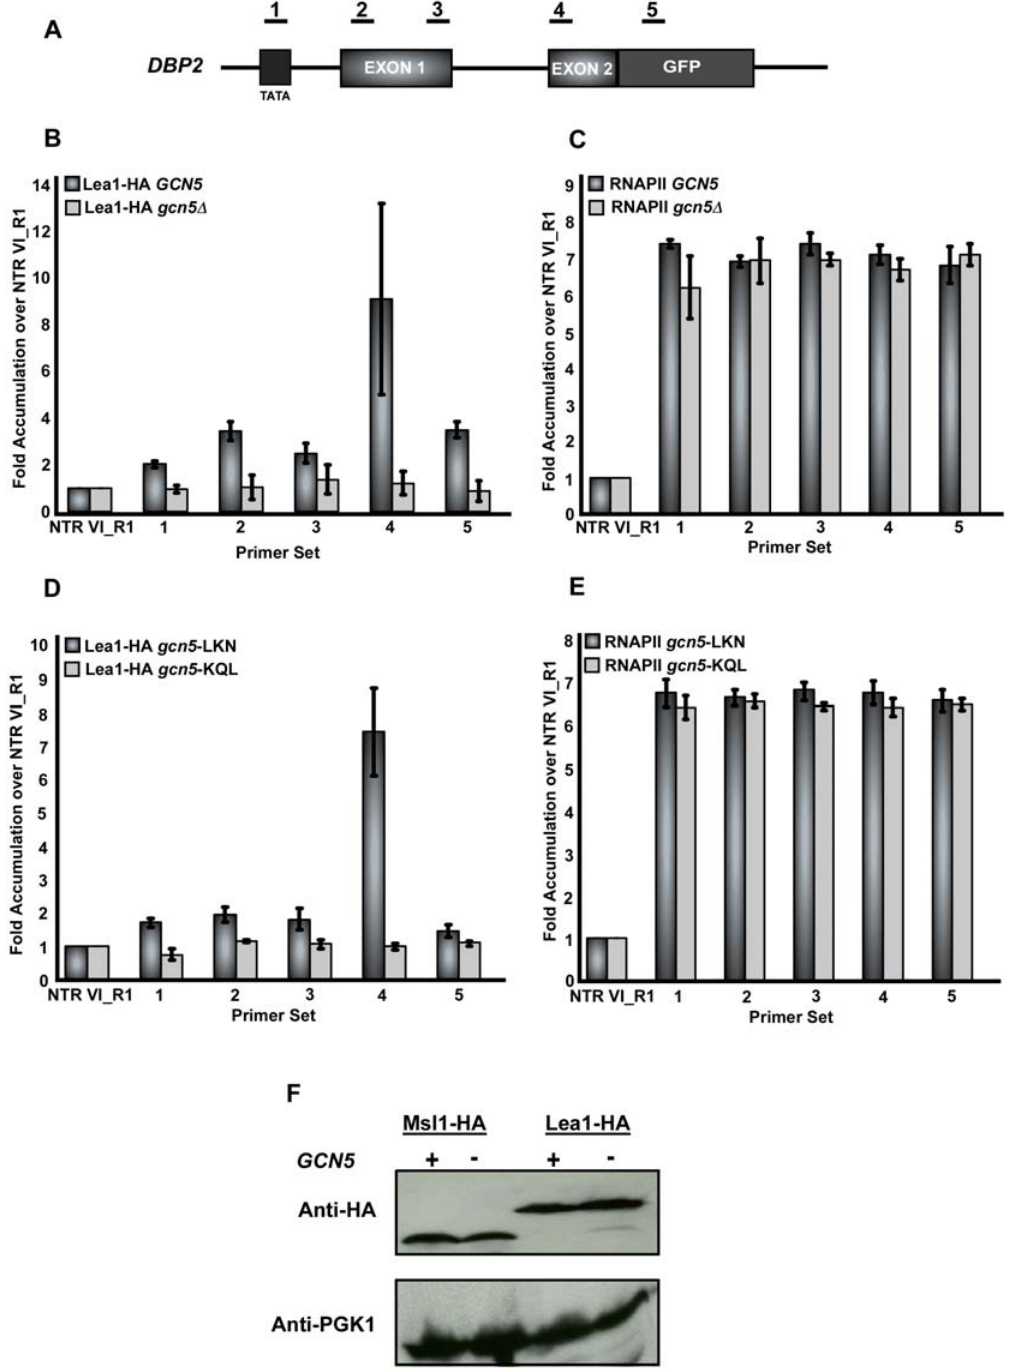
Figure 3. Deletion of GCN5 affects co-transcriptional recruitment of Lea1 to DBP2 . (A) Schematic of the intron-containing gene, DBP2 . Underlined numbers represent amplicons generated from each primer set used in the study. (B) Graph depicting the occupancy of Lea1 at each region of DBP2 relative to the non-transcribed region, in wild-type or gcn5 D . Dark grey bars represent Lea1 with wild-type GCN5 and light grey bars represent Lea1 levels in the gcn5 D strain. (C) Bar graph depicting RNA pol II occupancy within DBP2 relative to the non-transcribed control. Dark grey bars represent RNAP II occupancy in the LEA1-HA strain and light grey bars represent RNAP II occupancy in the LEA1-HA gcn5 D strain. (D) Graph depicting the occupancy of Lea1 with the Gcn5 HAT mutants, LKN and KQL. Dark grey bars represent Lea1 with the Gcn5 LKN mutation, light grey bars represent Lea1 with the Gcn5 KQL mutation. (E) Bar graph depicting RNA pol II occupancy in the presence of the Gcn5 HAT mutants. Dark grey bars represent RNA pol II occupancy with the Gcn5 LKN mutation and light grey bars represent RNAP II with the Gcn5 KQL mutant. All graphs depict the average of at least three independent experiments, and error bars represent the standard deviation. (F) Protein Immunoblot of strains used for ChIP assays. Wild-type and gcn5 D cultures were grown in YPD liquid medium and whole cell extracts were prepared (see Material and Methods) and probed with anti-HA 12CA5 (Roche), shown in the top panel. Extracts were also probed with anti-PGK1 (Invitrogen/Molecular Probes) as a loading control (bottom panel).